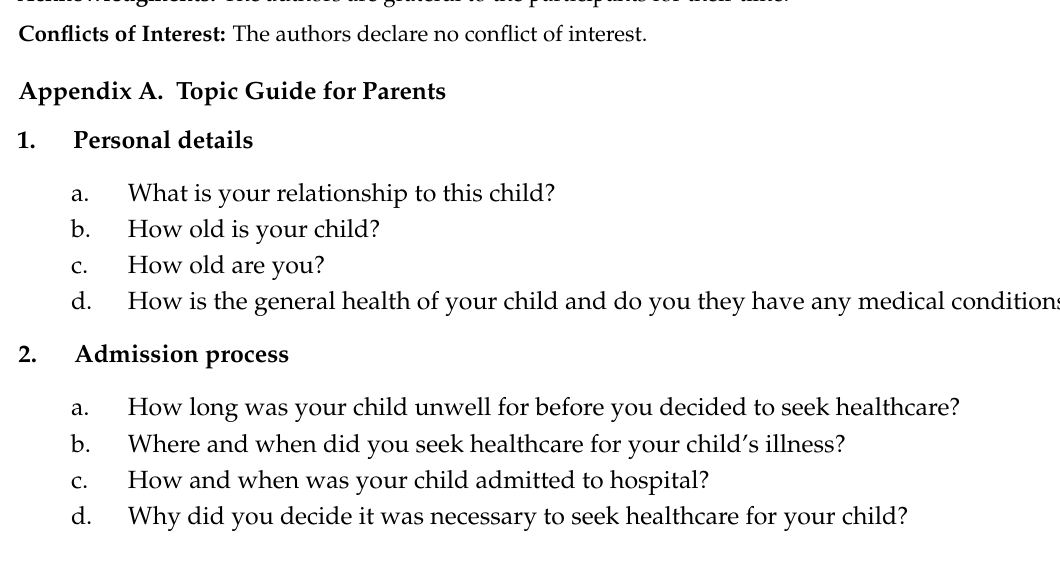
s1, Table S1: characteristics of referring clinicians, Table S2: characteristics of receiving clinicians, Table S3: characteristics of parents/caregivers and their